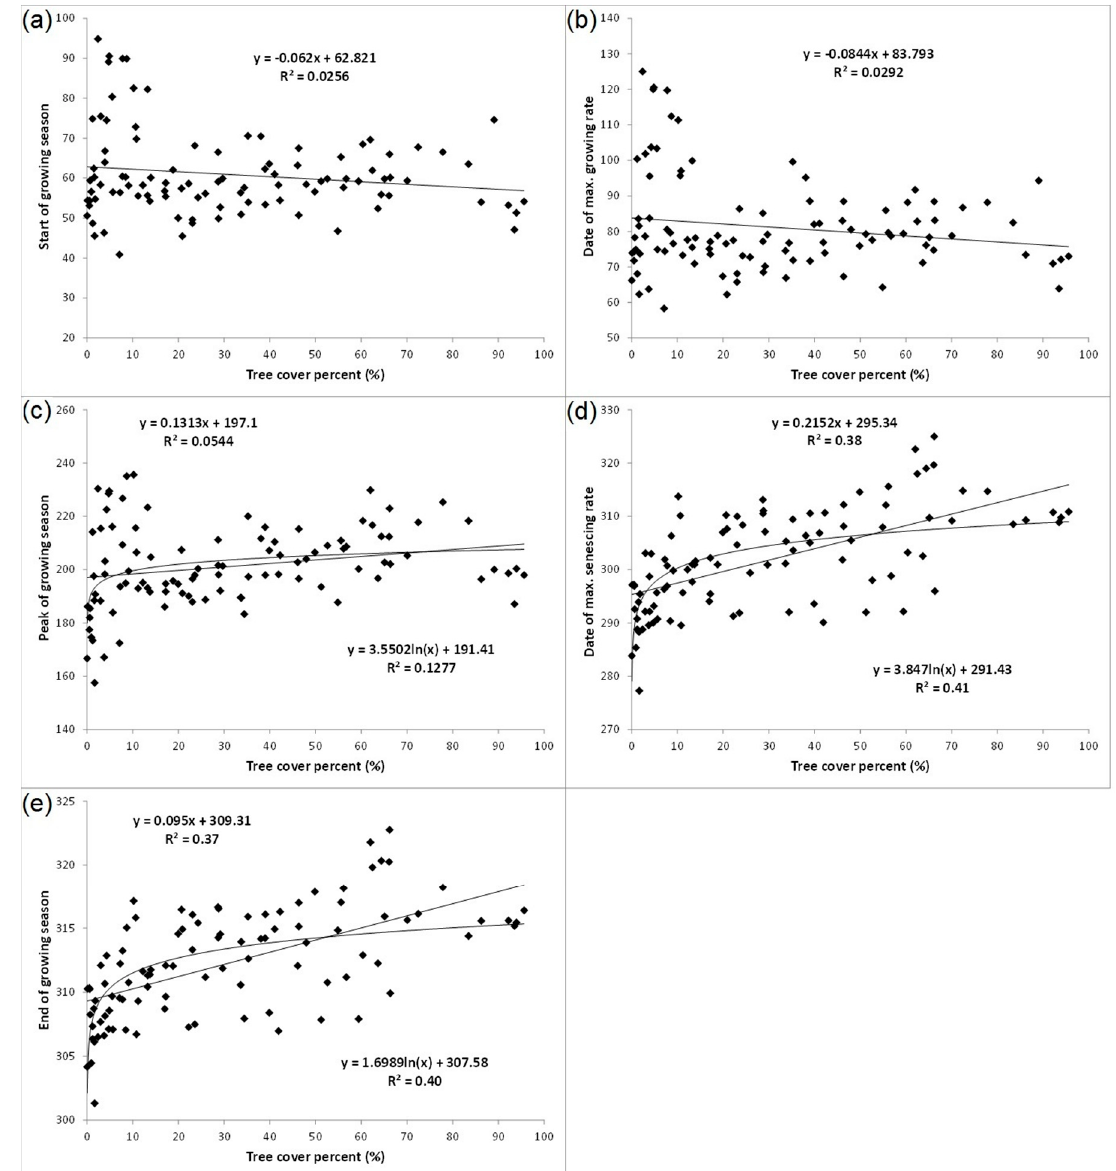
Figure 8. Linear regression analyses between tree cover (%) and landscape phenological metrics for day of the year at: ( a ) start of growing season; ( b ) maximum growing rate; ( c ) peak production; ( d ) maximum senescing rate; and ( e ) end of growing season. The growing season used in the study ranges from 4 July (Julian Day 185) of one year to 26 June (Day 177) of the following year.